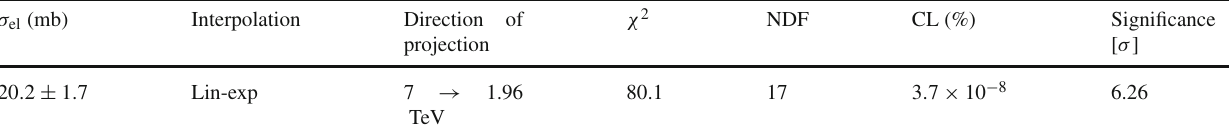
Table 7 Summary table of the significant Odderon signal in the one- way comparison of the H ( x ) scaling functions of proton–proton col- √ s = 7 TeV, as measured by the TOTEM experiment lisions at at CERN LHC [28,74], and proton–antiproton elastic collisions at